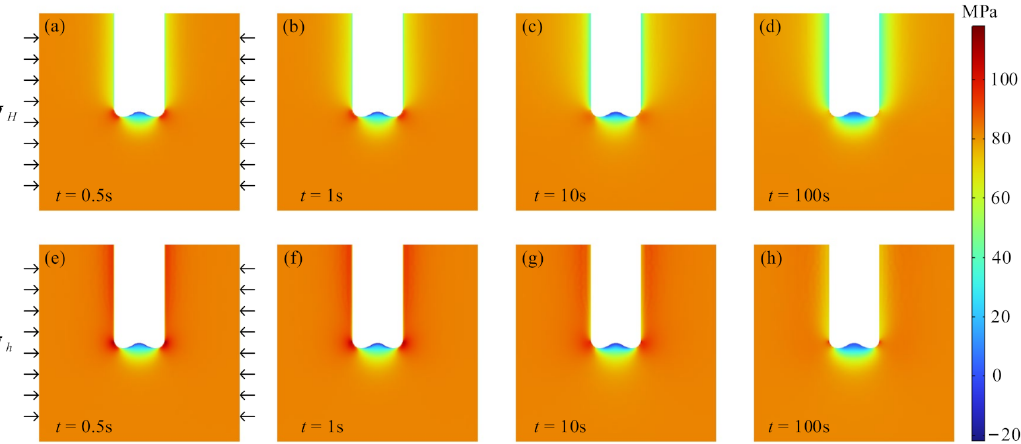
Figure 6. Average effective stress of the formation around the wellbore after drilling. ( a ) t = 0.5